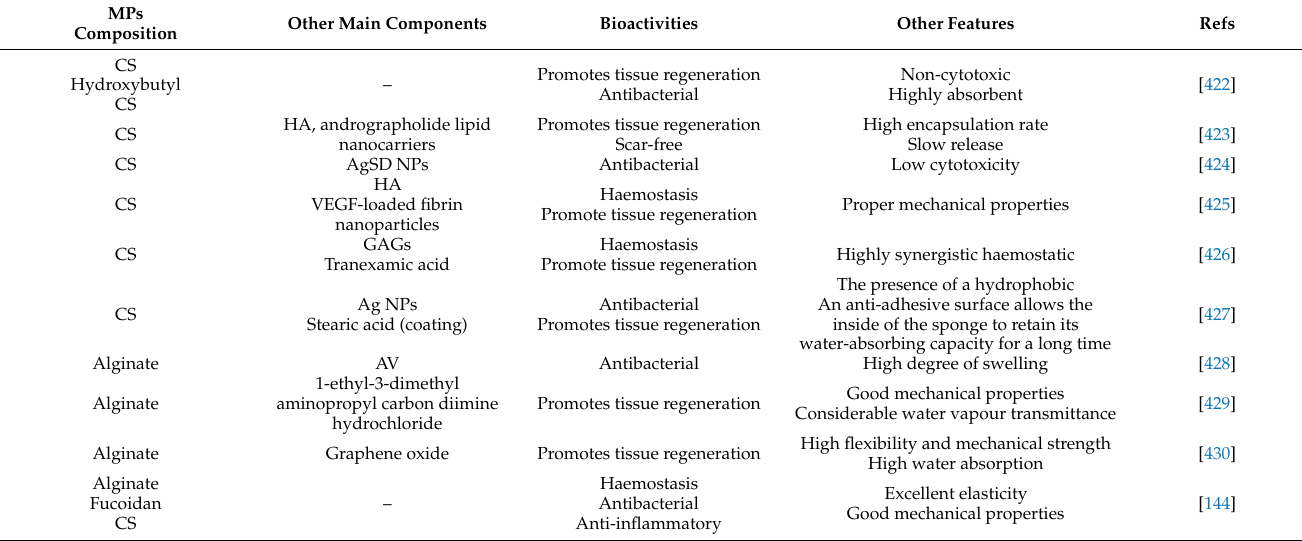
Table 10. Summary of raw materials and characteristics of MPs-based sponge dressings in recent